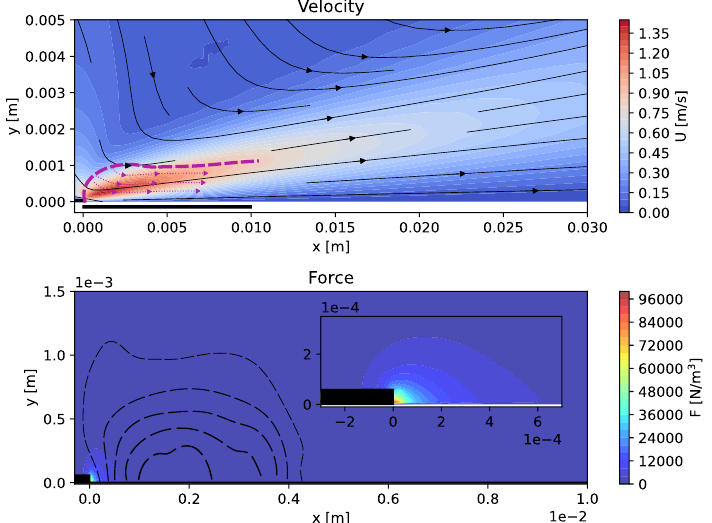
Figure 7. Unmodified Suzen model velocity field ( top ) and force ( bottom ) at 12 kV and 2 kHz. Purple lines and arrows are the reference wall jet, black arrows are the streamlines of the numerical results.